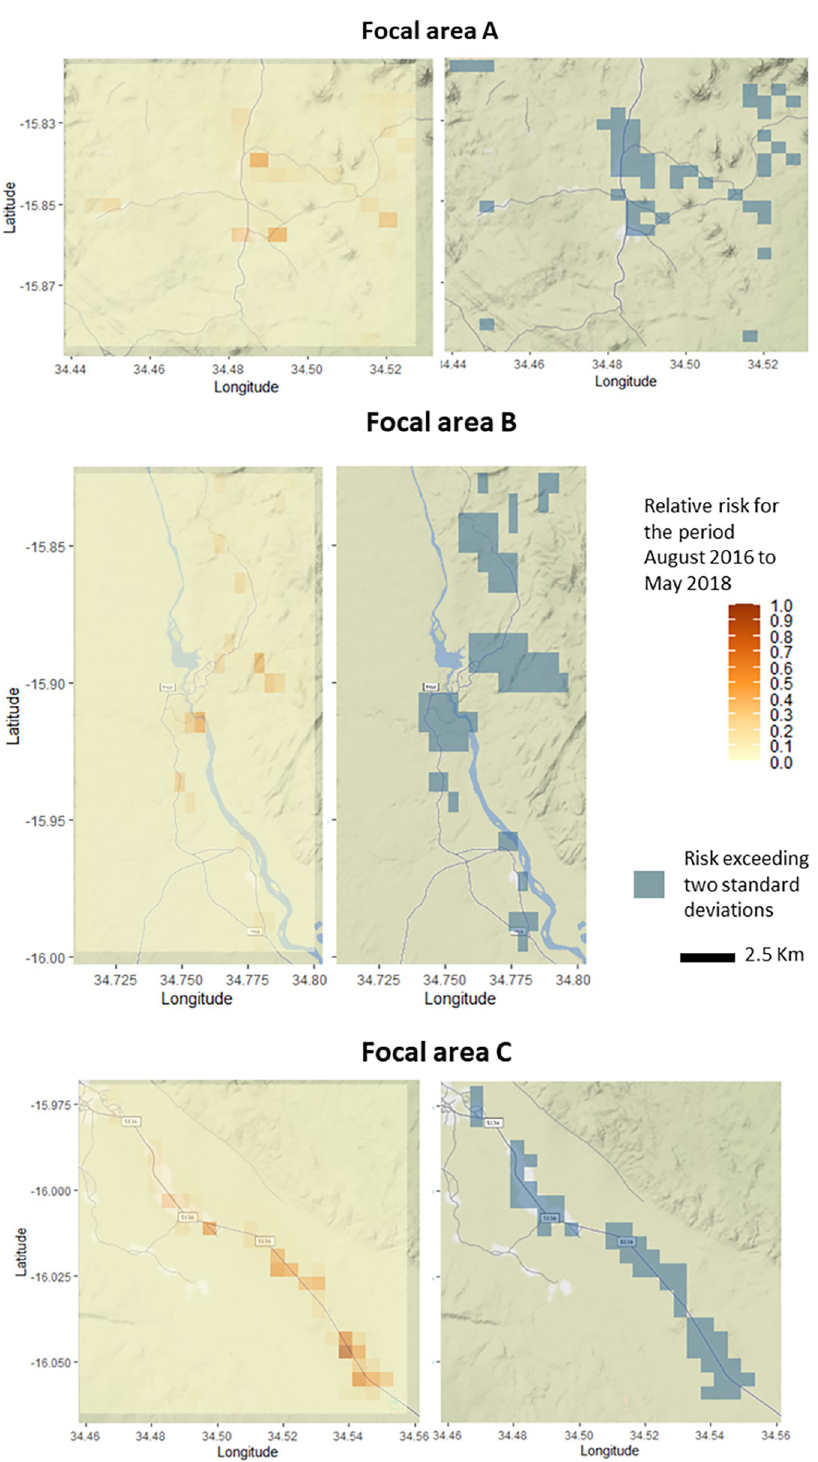
Fig 6. Relative risk of getting infected per day (left) and risk exceedance (right) maps for each focal area.